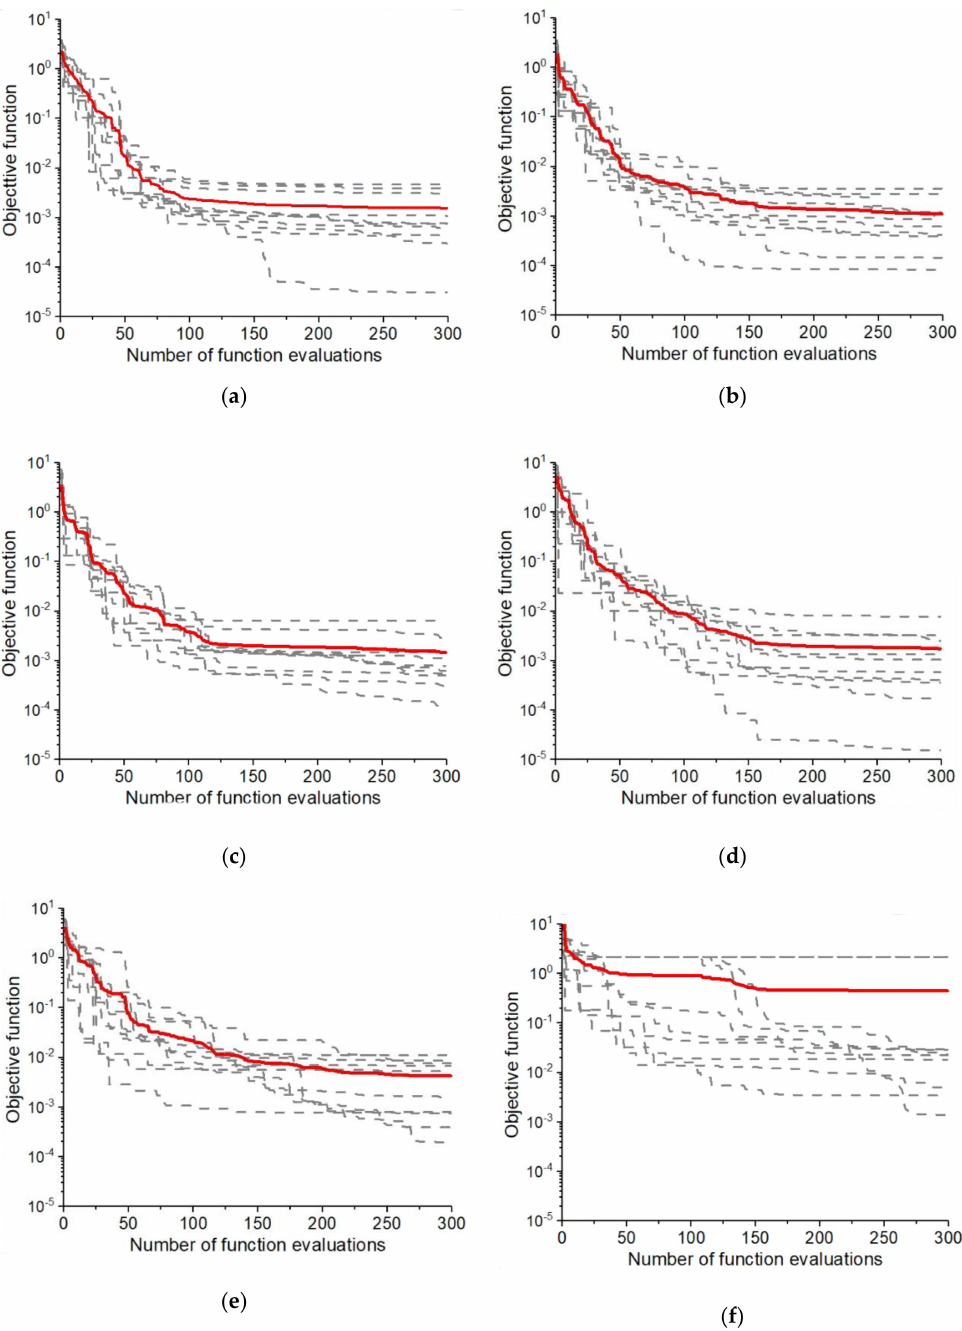
Figure 8. Evolution of the objective function values at varying pressure drops of ( a ) 0.3 MPa, ( b ) 0.25 MPa, ( c ) 0.2 MPa, ( d ) 0.15 MPa, ( e ) 0.1 MPa, and ( f ) 0.05 MPa: the dashed lines are for 10 individual and independent runs, whereas solid lines are averaged values of the independent